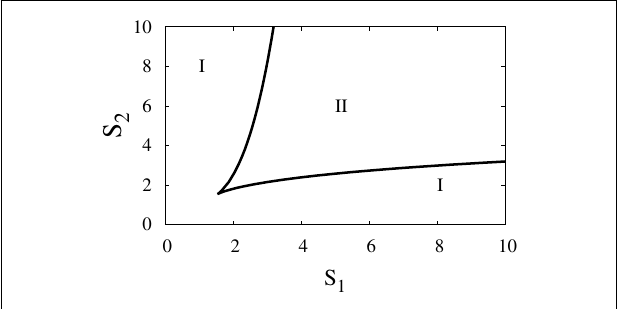
FIGURE 9 |Two-parameter bifurcation diagram .The bifurcation in the parameter space ( S 1 , S 2 ), where S 1 and S 2 are external signals in the genetic switch.The borders separate between the regions of monostability I and the region of bistability II . Parameters are a 1 = a 2 = 0.05, b 1 = b 2 = 0.45, r = 0.5, k 1 = k 2 = 1.